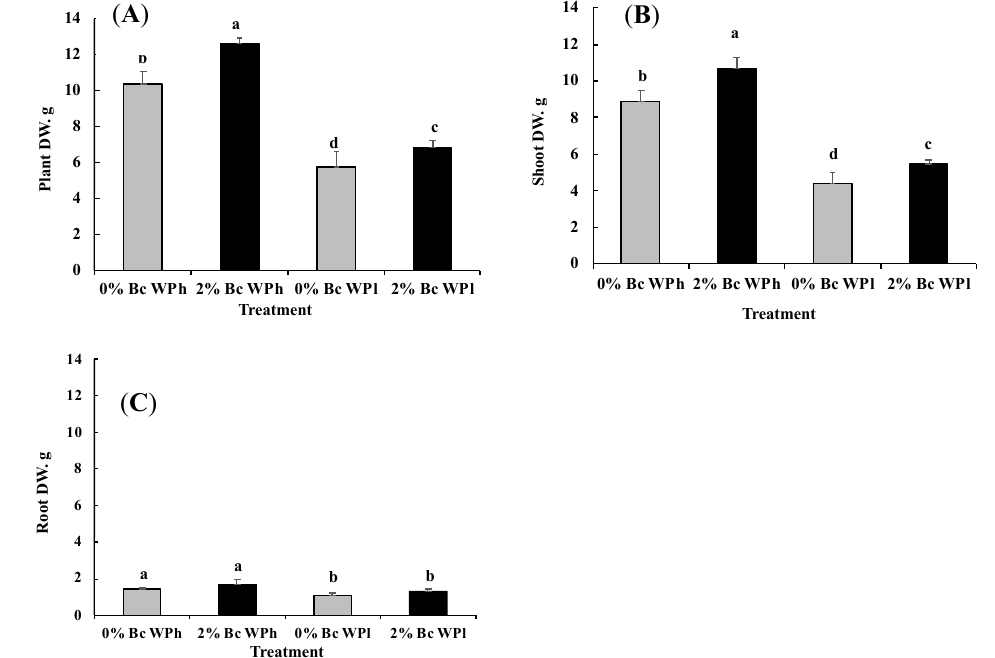
Figure 1. Varietal differences in plant growth parameters; dry weight of the whole plant ( A ), shoot ( B ), and the root ( C ), in Medicago ciliaris after 3 weeks of drought treatment. Values represent mean ± SE ( n = 5) and the different letters a to d indicate significant differences between the treatments. Low soil water potential (WPl), high soil water potential (WPh), Biochar (Bc). The negative values of the sensitivity index (SI) under water deficit conditions reflect a growth-reduction (Table 1) and the positive values of SI at 2% Bc reflect a growth stim- ulation even under water deficit conditions. Table 1. Relative impact (SI in %) of drought and biochar on the dry weight of Medicago ciliaris plant, shoot and root. Low soil water potential (WPl), high soil water potential (WPh), Biochar (Bc). Sensitivity Index (SI)